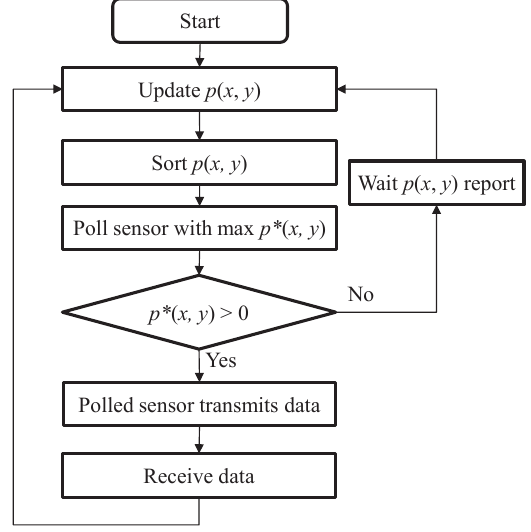
Figure 2. Operation procedure at the HAP under the proposed polling protocol. The polling messages include the polling beacon from the HAP to wireless sensors and the polling response from wireless sensors to the HAP. The polling beacon includes at least two fields: the identity (ID) field, indicating the ID of a polled wireless sensor, and the reservation field for each wireless sensor. As for the polling response, it includes at least the reservation field for wireless sensors (two bits for each wireless sensor), as shown in Figure 3. For simplicity, the other fields such as the preamble for synchronization are omitted in Figure 3. When a wireless sensor receives a polling beacon from the HAP, it can request charging by setting its reservation value to 1 in the corresponding bit of the polling response message and sending it to the HAP. When a wireless sensor wants to stop charging, it can set the reservation value to 0 and send it to the HAP. The HAP always notifies wireless sensors of their charging statuses in each polling beacon. When a wireless sensor is polled by the HAP, i.e., receiving a polling beacon with its ID, it then immediately transmits its DP right after the entire polling response message